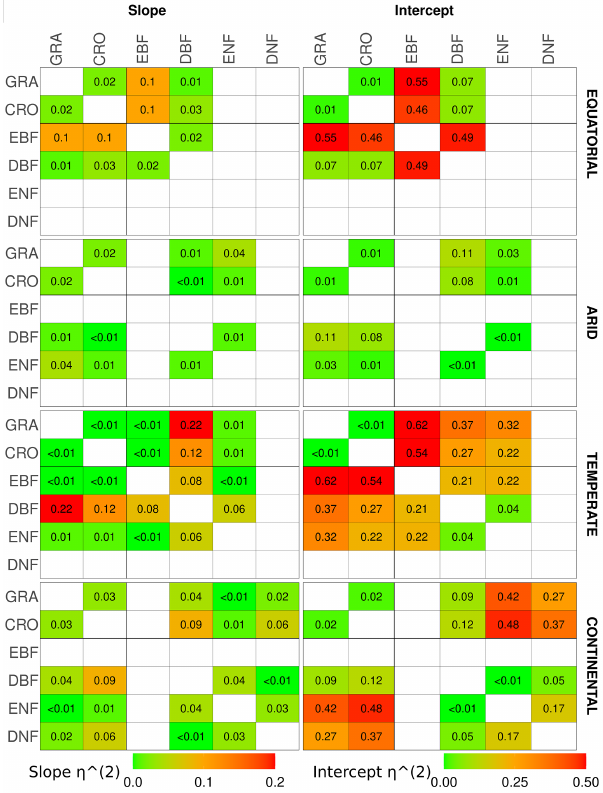
Figure A4. The η 2 parameter of an analysis of covariance be- tween pairs of vegetation covers in different Köppen–Geiger cli- mate groupings, for the slope (left) and intercept (right) of the lin- ear relationship between downscaled SIF and FluxSat GPP. AN- COVA is performed on the intercept under the assumption that the difference between slopes is not significant. The η 2 parameter is comparable to the percentage of the difference in the slope or in- tercept (the latter assuming equivalence of the slopes) attributable to the difference in vegetation cover, with lower values signifying a smaller difference between vegetation covers. A slightly bolder line is used to separate the herbaceous species (CRO, GRA) from the woody species (EBF, DBF, ENF,